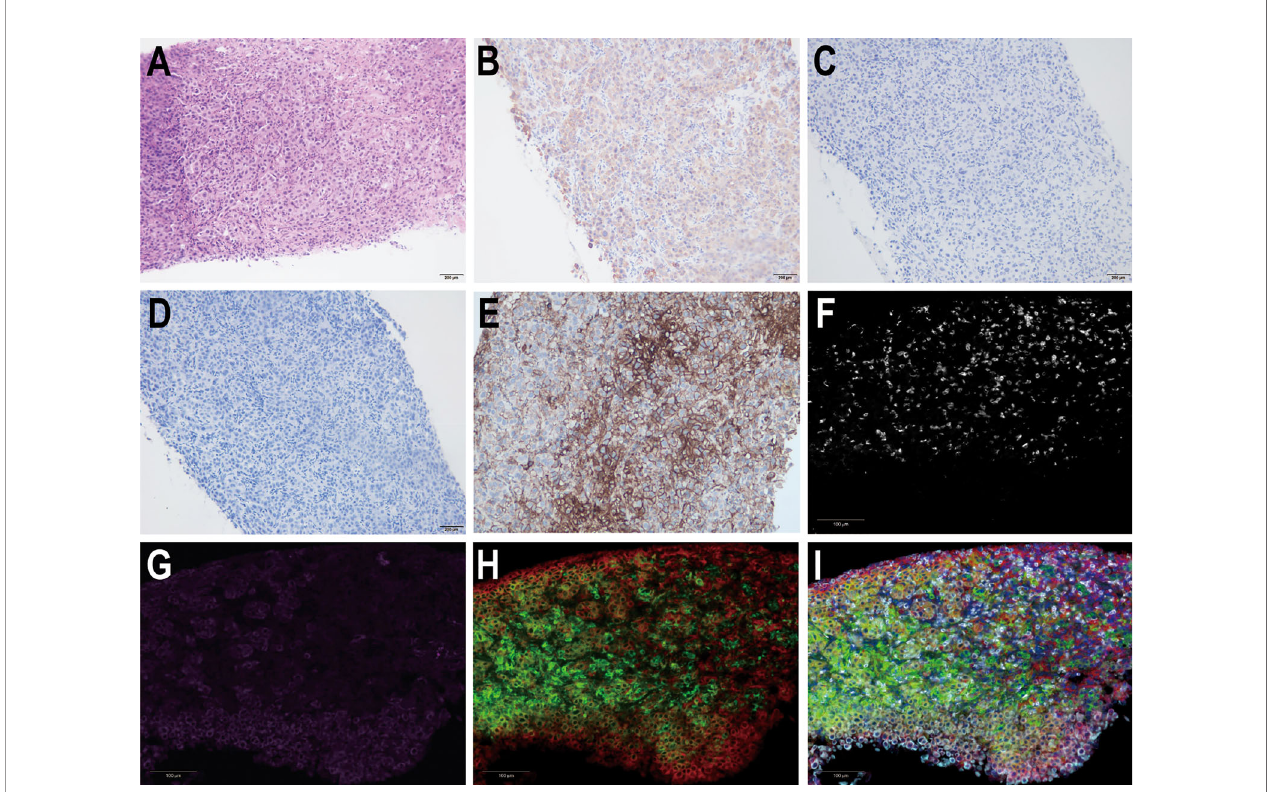
FIGURE 2 | Hematoxylin-eosin (HE) staining and immunohistochemical analysis of liver tumor tissue from the needle biopsy. Pathological images show (A) HE staining (200×), (B) positive CK19 staining, (C) negative AFP staining, and (D) negative hepatocyte staining. (E) Immunohistochemical staining for PD-L1 expression (200×). Multiple fl uorescence immunohistochemical images show (F) the CD8+T cells, (G) the natural killer (NK) cells, (H) the macrophages, and (I) the merged images of the previous three images.